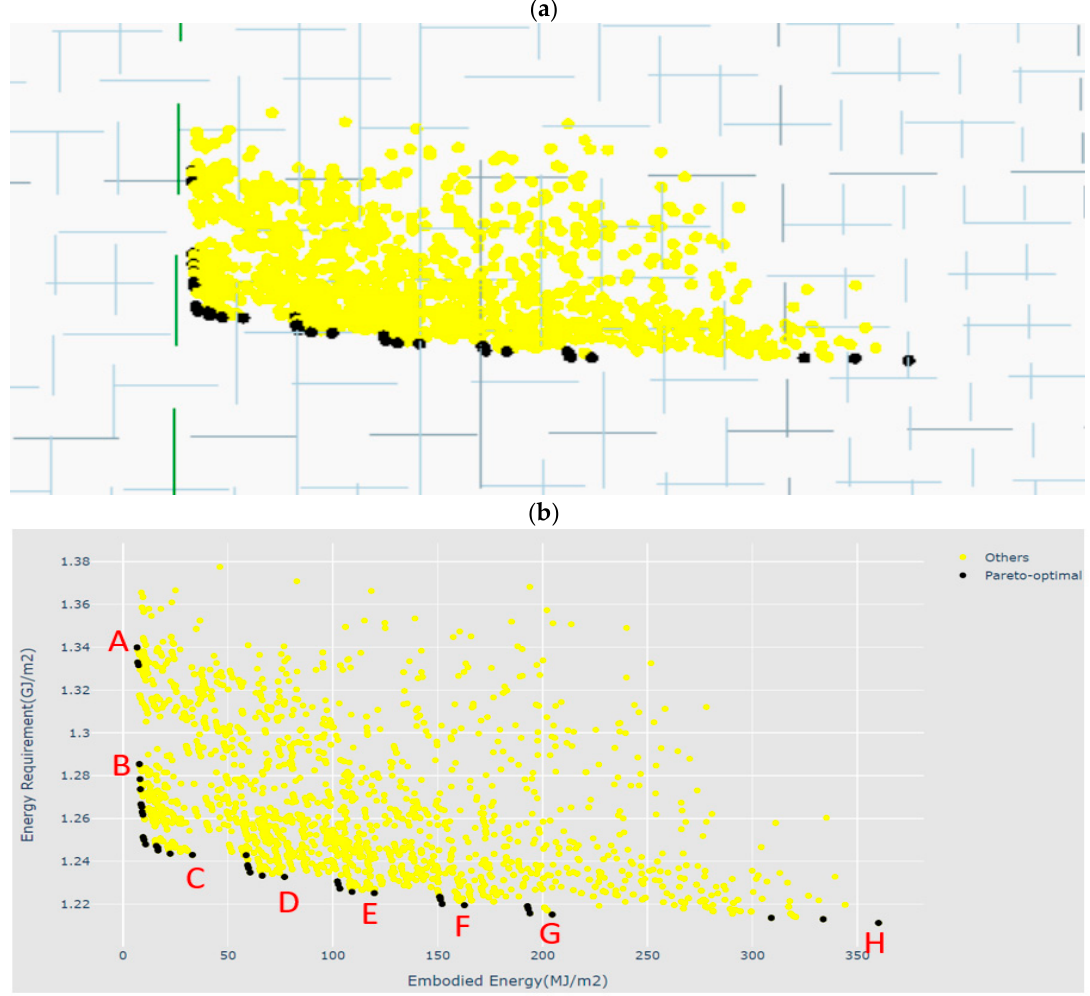
Figure 11. ( a ) Case Study Data Visualisation in Dynamo, and ( b ) 2D Scatter Plot.